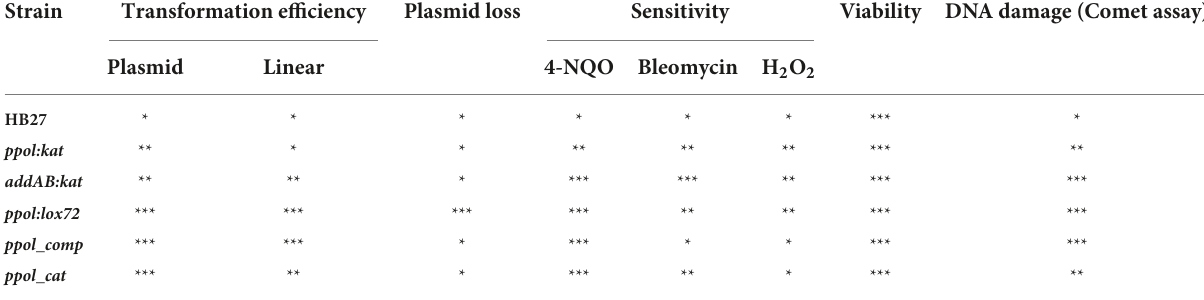
TABLE 2 Strains studied in this work and their resultant phenotypes. Strain Transformation